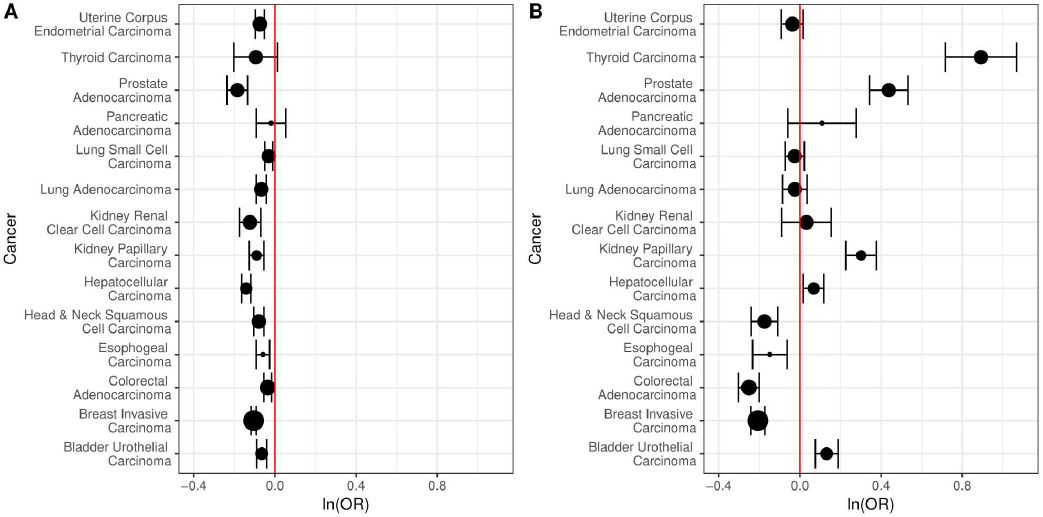
Figure 7. The log odds of intersecting regions of copy number alteration in bidirectional vs. single gene promoters, restricted to CpG islands. The size of the points indicates the relative sample size and 95% confidence intervals are shown. ( A ) The odds of intersecting regions of copy number alteration are lower for the 657 C/C bidirectional compared to 5003 single gene promoters, across all 14 cancers. These results are statistically significant for 12 out of 14 cancers; ( B ) For the 97 C/N bidirectional compared to single gene promoters, the odds of intersecting regions of copy number alteration are lower for only half the cancers. The results are significant in 8/14 cancers.